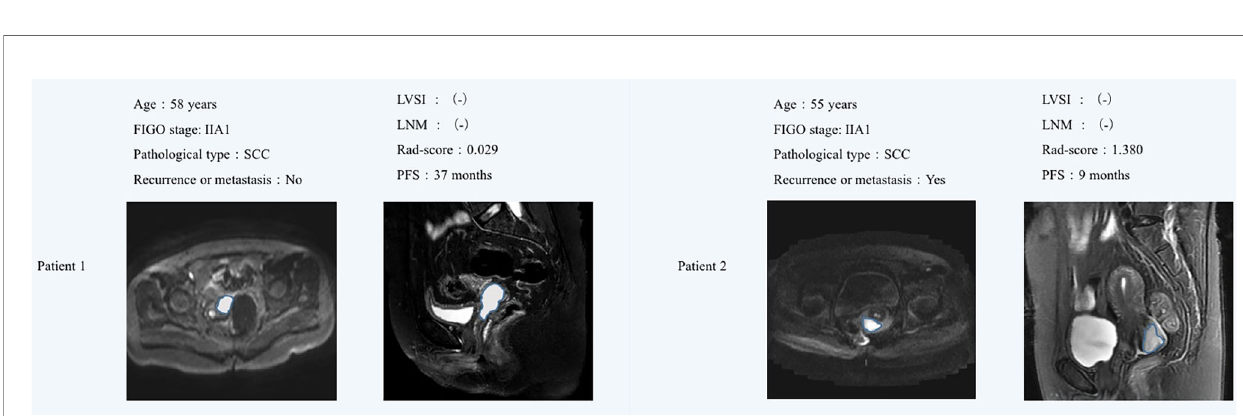
FIGURE 2 | Kaplan – Meier survival curves of progression-free survival according to the Rad-score in the training cohorts (A) and independent validation data set (B) . Shadows represent 95% con fi dence interval. HR, hazard ratio.